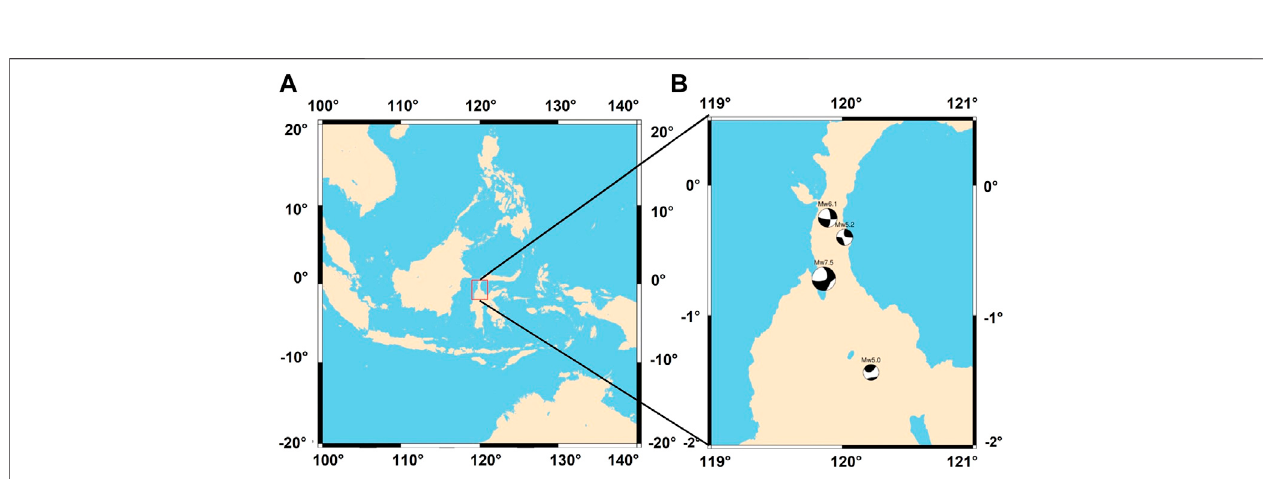
FIGURE9| Distribution ofTECand SIPanomalieson3Dtomographicmodelsofthe2018.PaluEarthquakeat 10.16UT(~13minutesafter theearthquake).Black circle is the SIP where CIDs occur that are detected from GPS satellites 21 and 25.